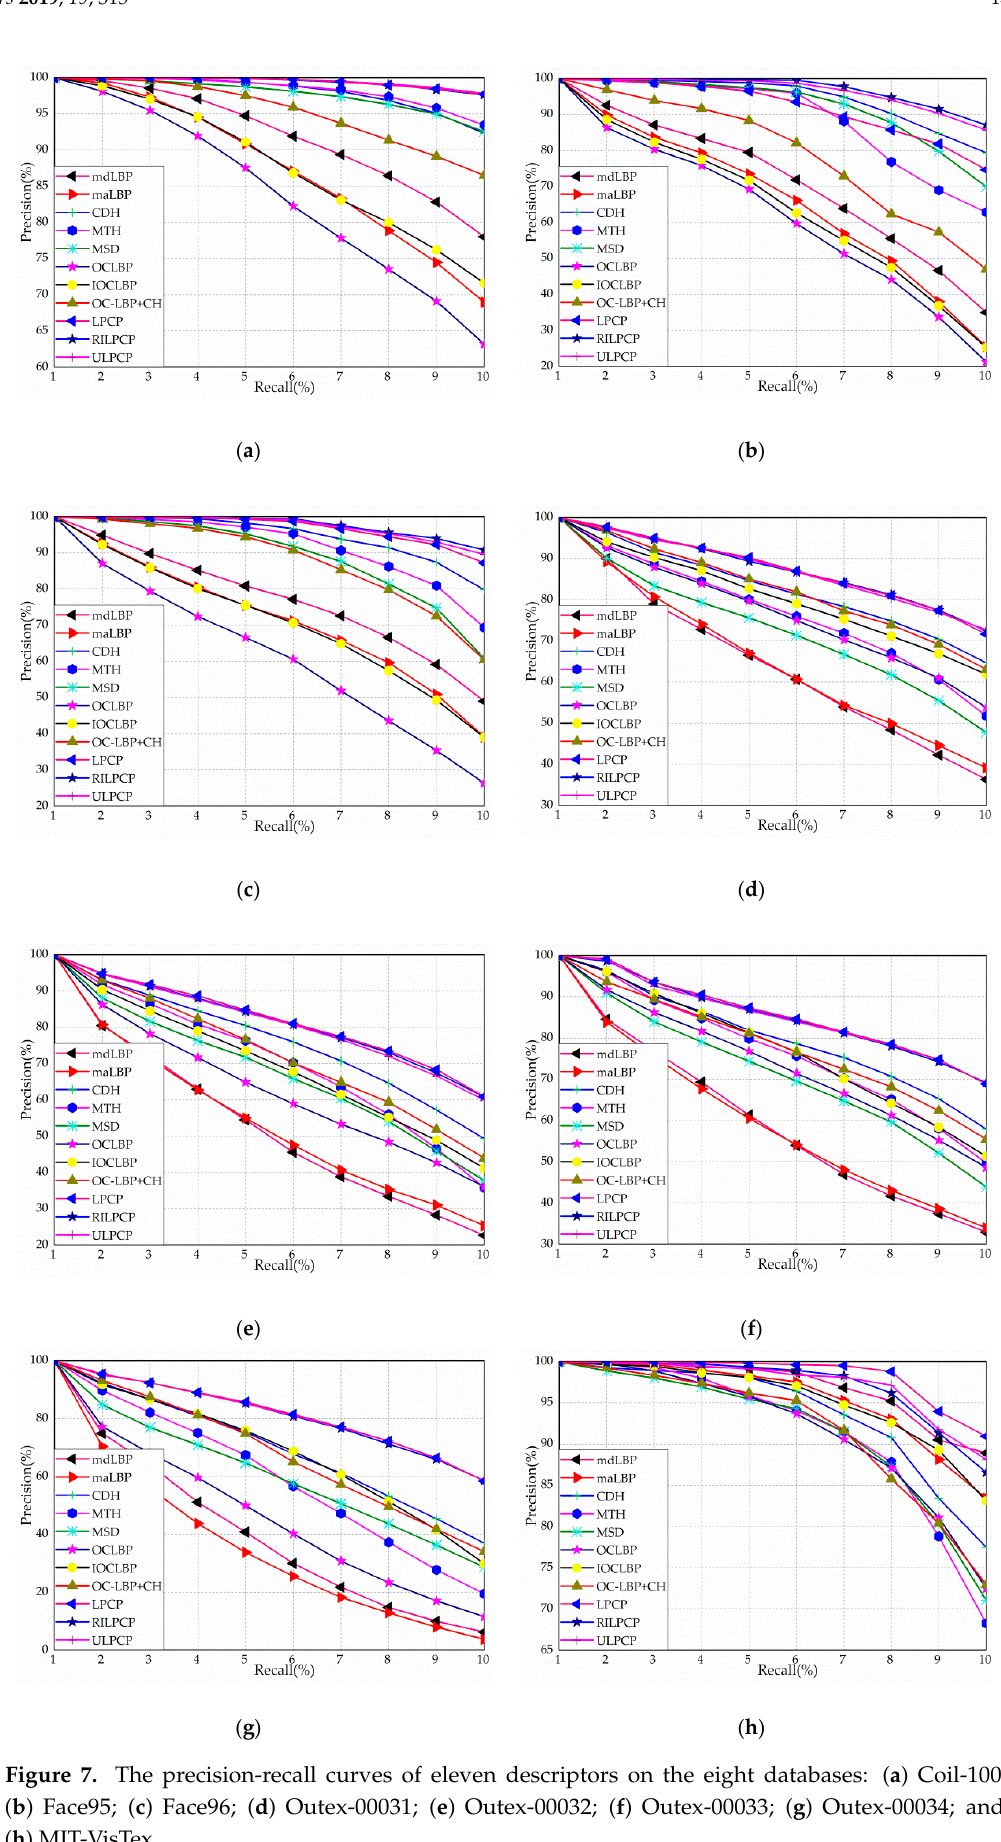
Figure 7. The precision-recall curves of eleven descriptors on the eight databases: ( a ) Coil-100; ( b ) Face95; ( c ) Face96; ( d ) Outex-00031; ( e ) Outex-00032; ( f ) Outex-00033; ( g ) Outex-00034; and ( h ) MIT-VisTex.